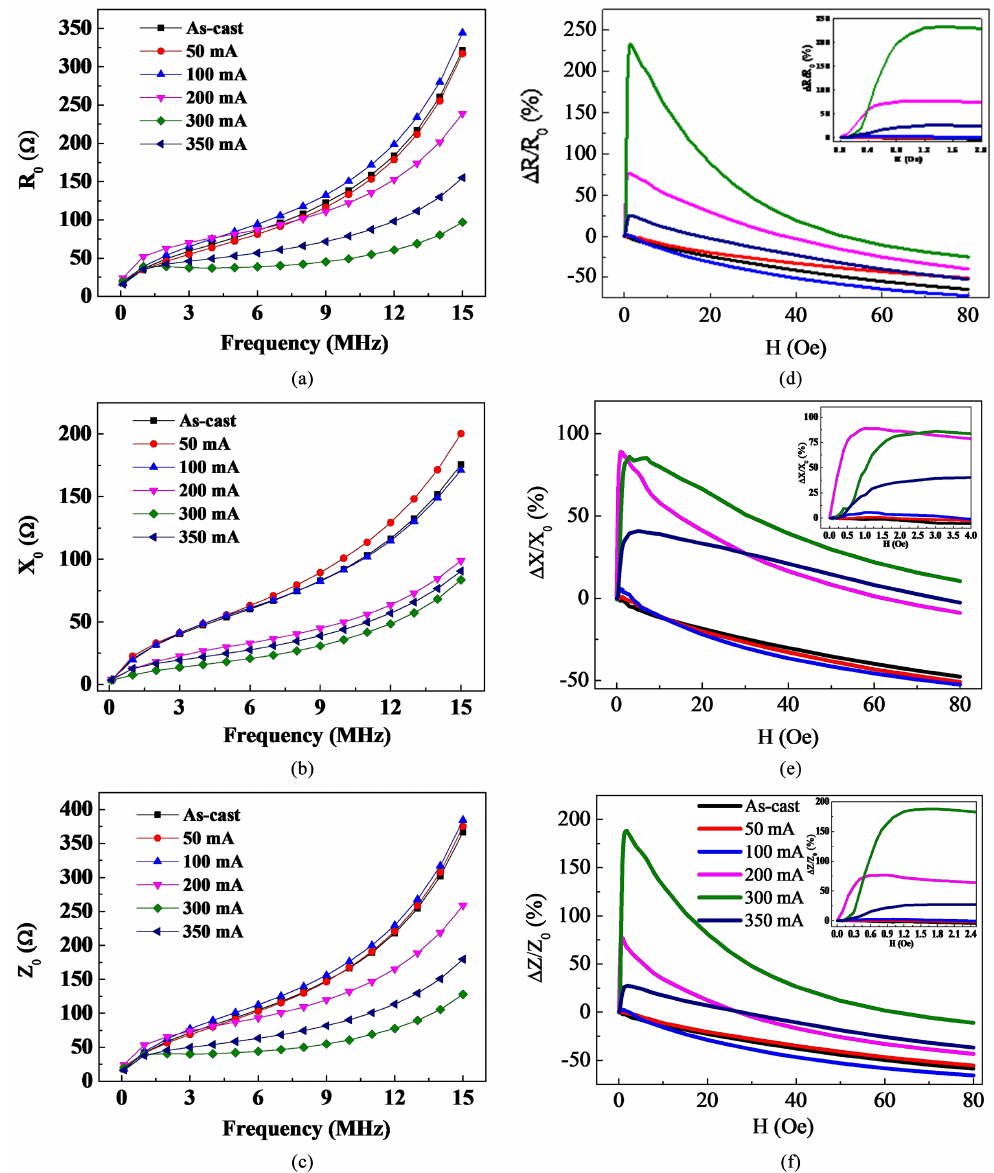
Figure 3. Frequency dependence of (a) resistance R ( H (d) magneto-resistance (Δ R/R range of 0~350 mA. Insets of the magnified peak positions of Δ R/R